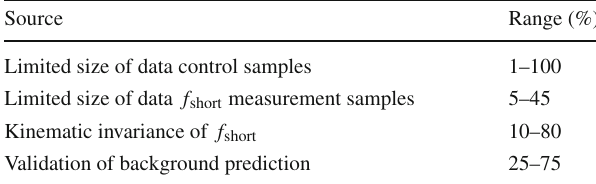
Table 5 Summary of systematic uncertainties in the disappearing track background prediction, togetherwiththeirtypicalsizeranges across the search bins. The systematic uncertainties arising from the assumption of kinematic invariance of f short and from the validation of the back- groundpredictionarealwaystakentobeatleastaslargeasthestatistical uncertainties on the measured values of f short and on the background prediction in the validation region,